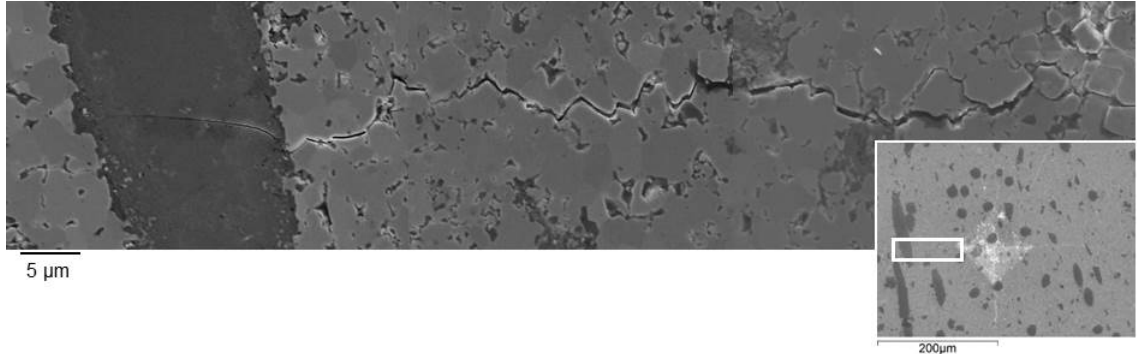
Figure 7. Crack path generated by a 98.1 N